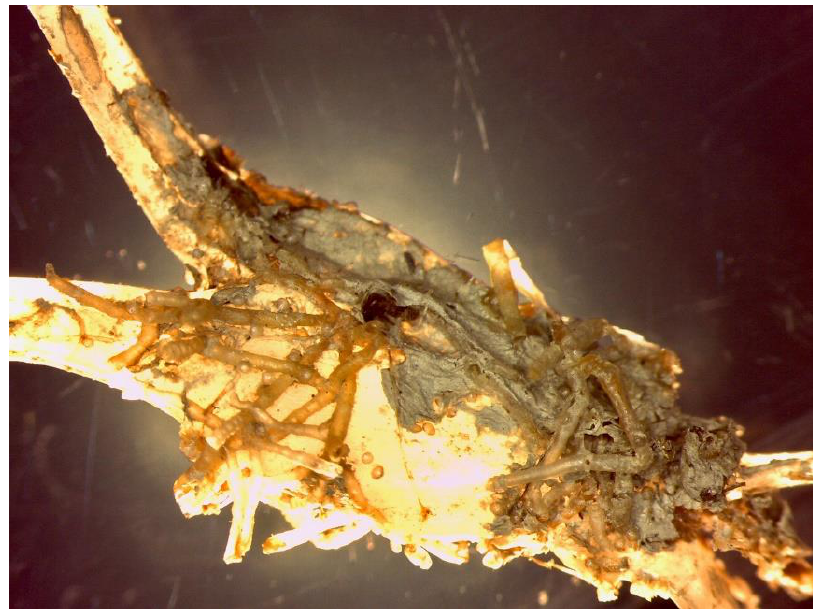
Figure 3. IR spectrum of new and dirty socks.